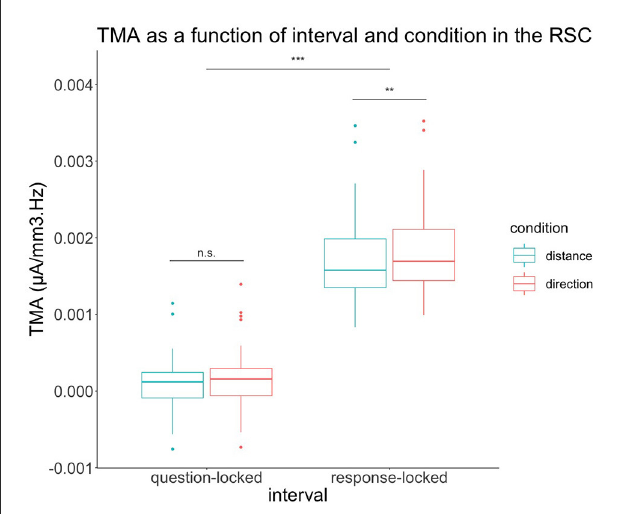
FIGURE4 TMA of retrosplenial cortex depending on condition and interval of the experiment. In the question-locked, there were no significant differences in TMA between the two conditions. In response-locked, the TMA of the condition direction is significantly greater than the distance condition. n.s: p > 0.05, ** p < 0.01, *** p <